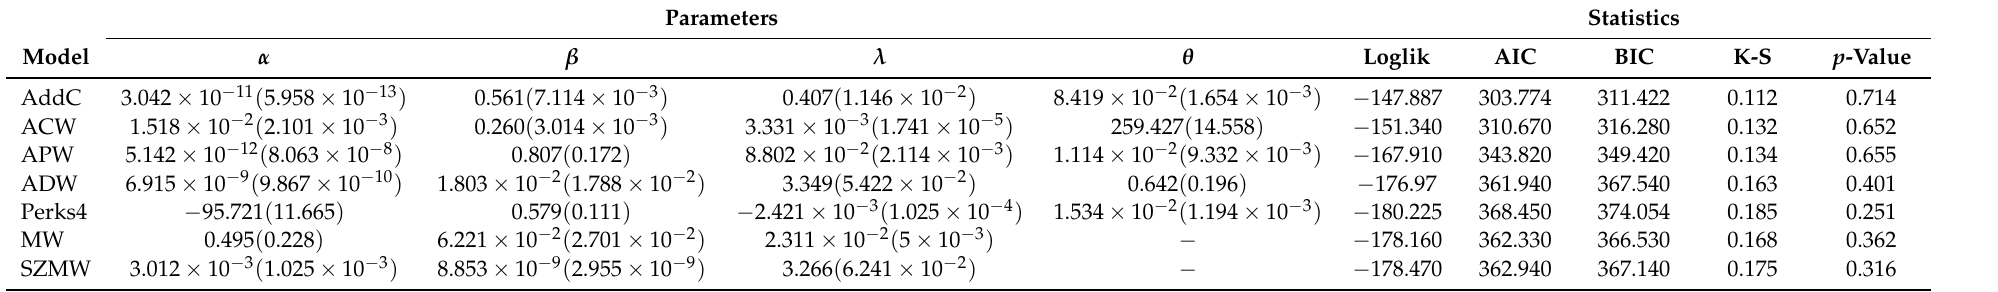
Table 5. Estimated Values, standard errors in brackets and Statistics metrics for the Case of Study